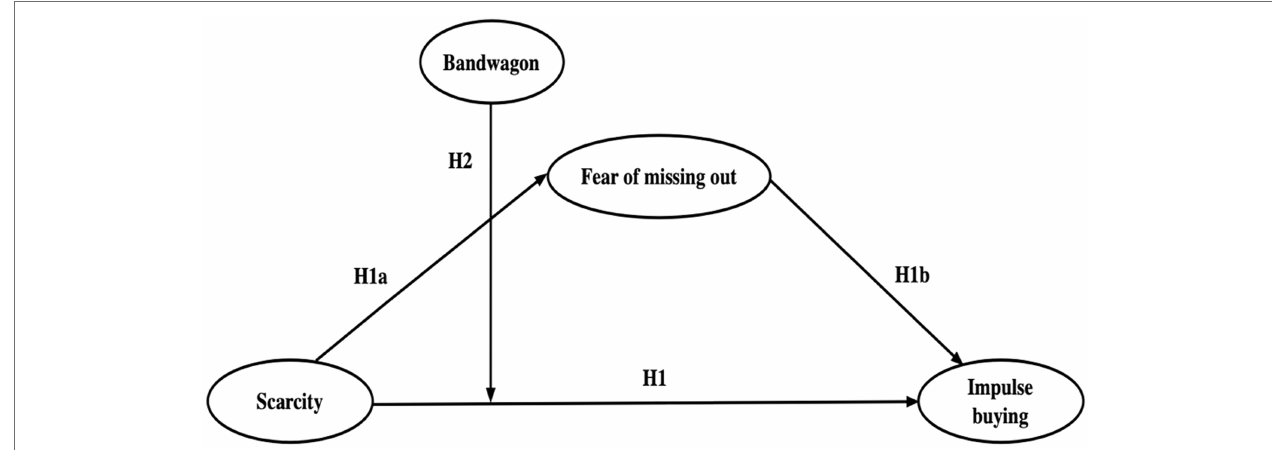
FIGURE 1 | Research